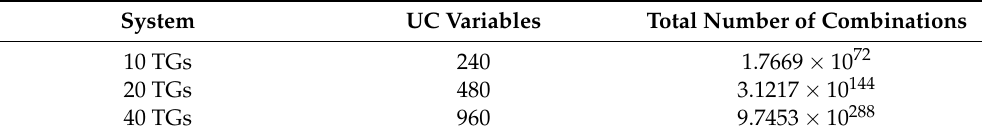
Table 4. Number of solution combinations for each analyzed system.